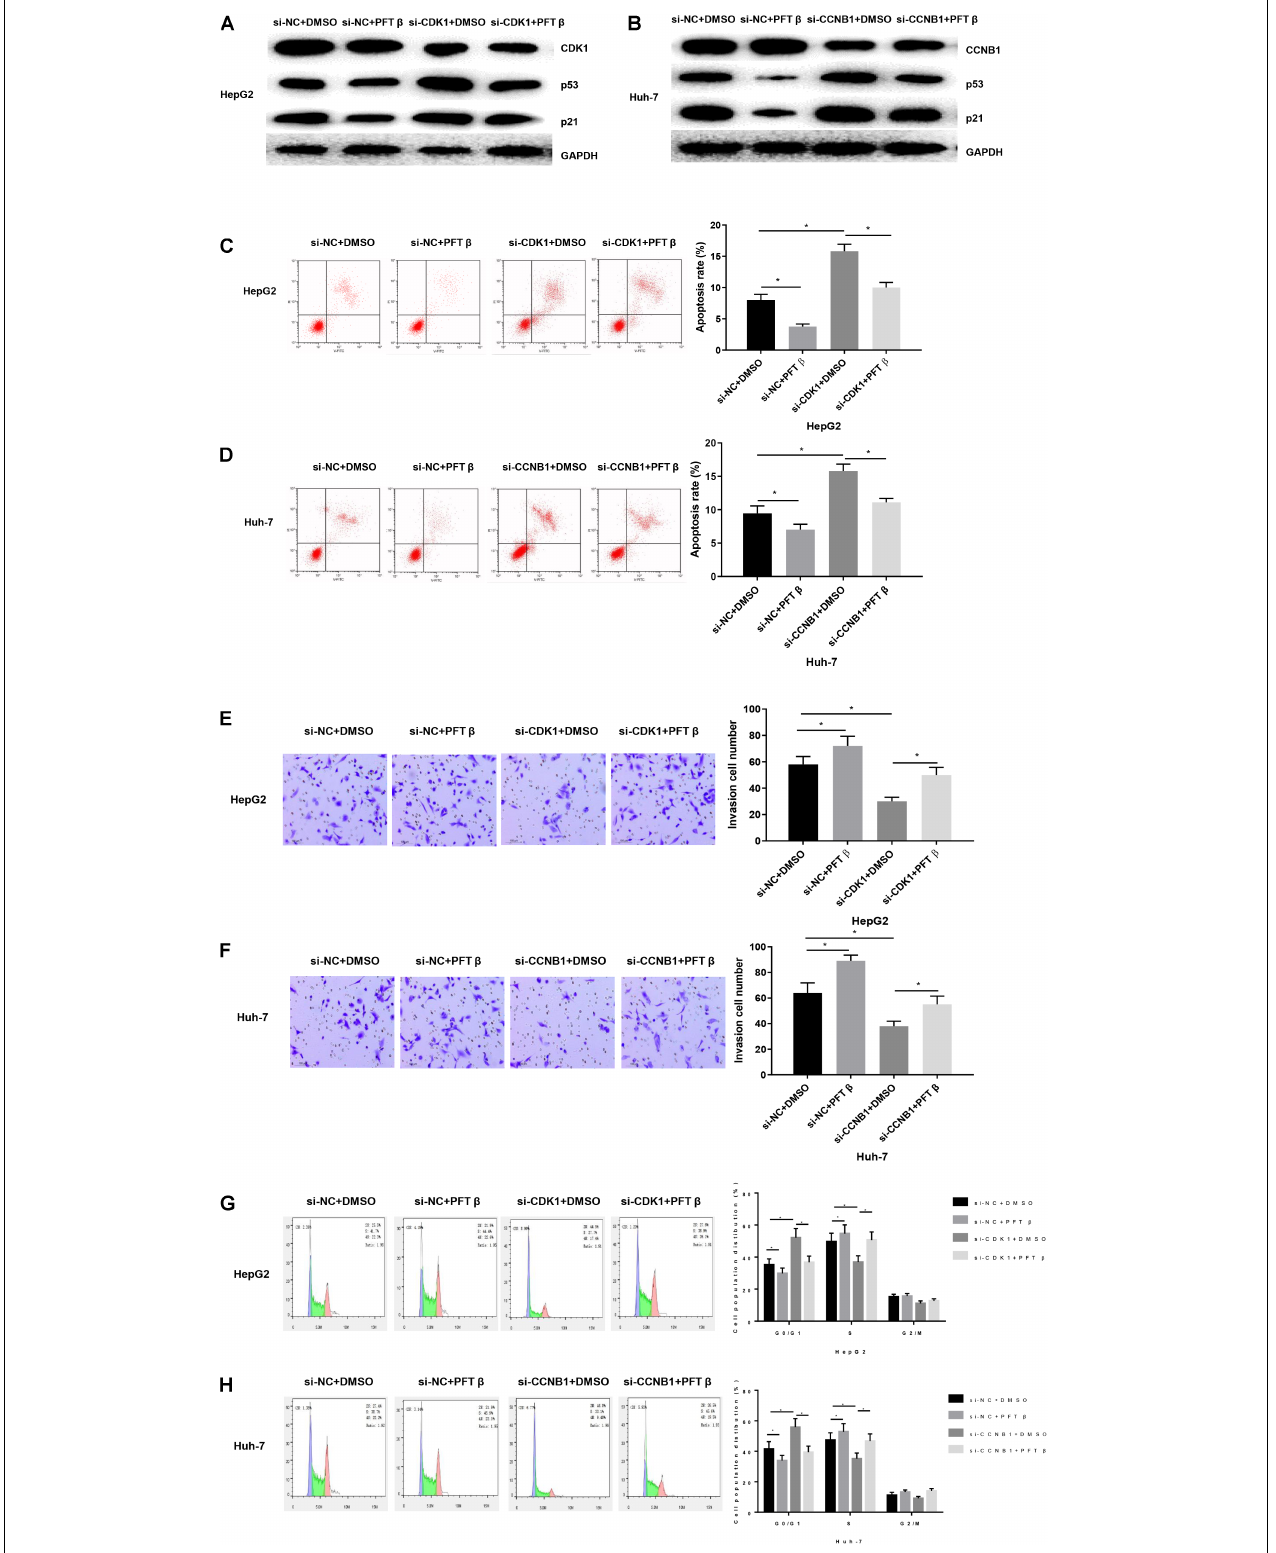
FIGURE 3 | CDK1 and CCNB1 affect the apoptosis, invasion and cell cycle of HCC by regulating p53 pathway. (A) The protein expressions of CDK1, p53 and p21 in HepG2 cells were detected by WB; (B) The protein expressions of CCNB1, p53 and p21 in Huh-7 cells were detected by WB; Cells development in each group was detected by FCM and Transwell assays (100 × ). (C,D) Cell apoptosis; (E,F) Cell invasion; (G,H) Cell cycle. *means P < 0.05.